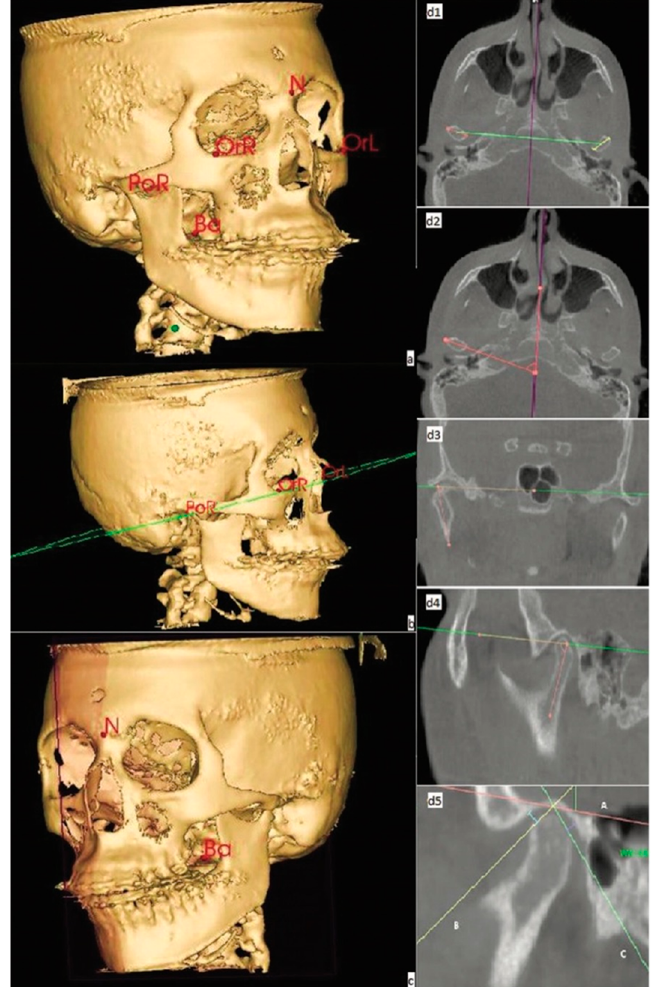
Figure 1. CBCT image evaluation: ( a ) midpoints of reference; ( b ) Frankfort horizontal plane; ( c ) mid- sagittal plane; ( d1 ) intercondylar distance; ( d2 ) condylar angulation in the axial plane; ( d3 ) condylar angulation in the frontal plane; ( d4 ) condylar angulation in the sagittal plane; ( d5 ) condylar position in the sagittal plane. Adapted from Vale et al. [23].